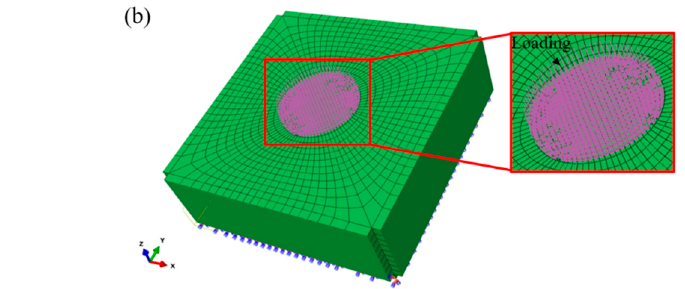
Figure 6. The FEM model of the single-point laser shock. ( a ) Numerical modal ( b ) Loading area.